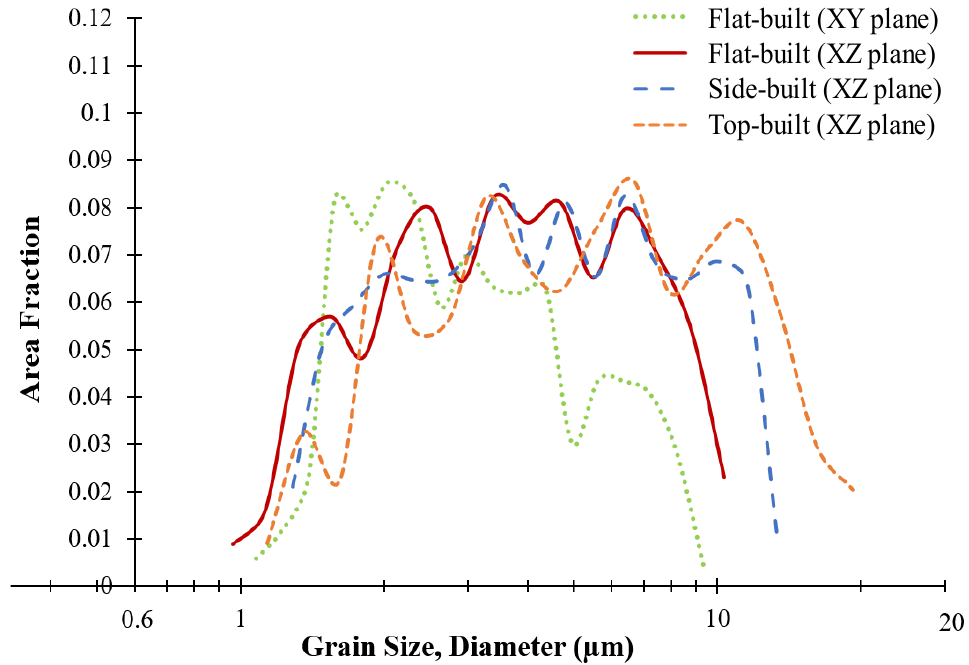
Figure 9. Grain size (diameter) distribution curves including average grain sizes of the flat-built, side-built, and top-built samples.